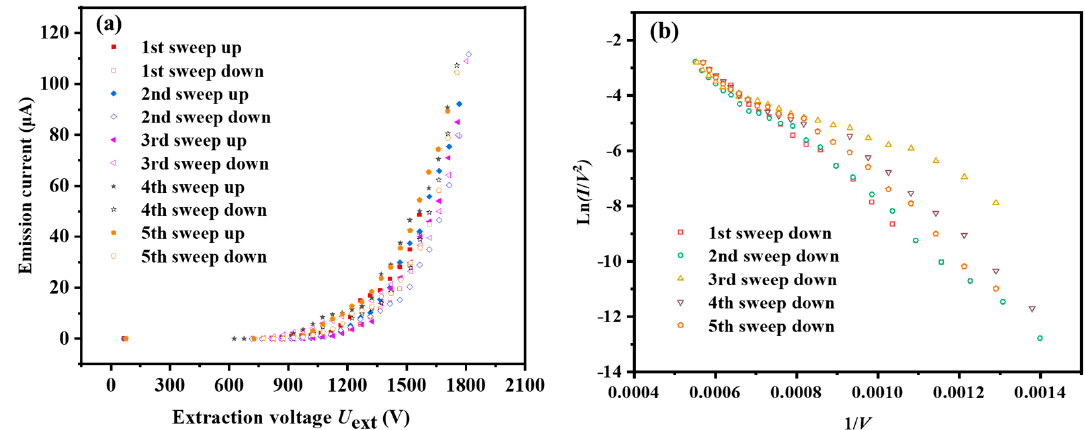
Figure 3. I - V property tests of multiple sweeps after 3 h of the conditioning process at a pressure of 1.2 × 10 − 6 Pa. ( a ) 5 times FE tests of up and down sweeps. ( b ) Ln( I / V 2 )-1 / V curve plotted from I - V data of down sweeping.